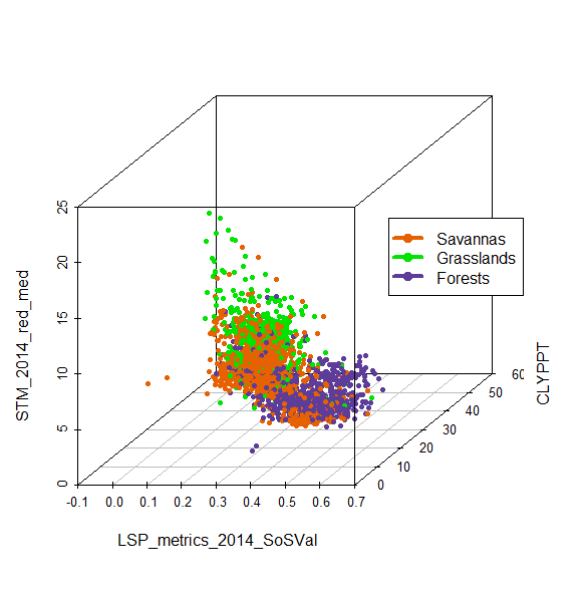
Figure 4. 3D-scatterplot of three of the most important variables for the level-1 classification model based on the Gini importance index.